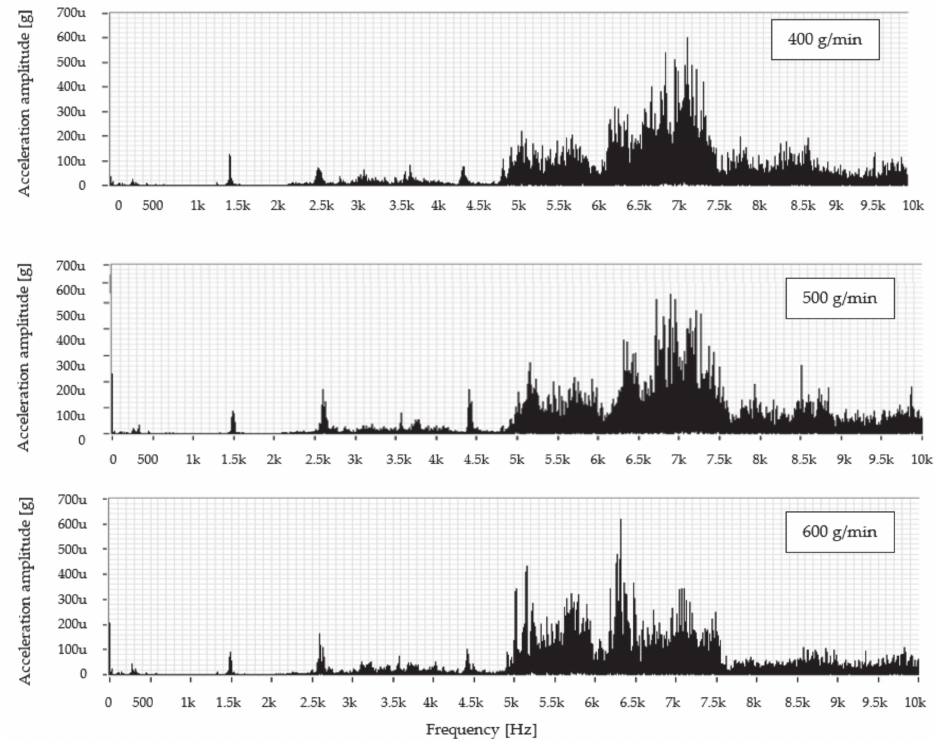
Figure 8. Frequency spectra of vibration acceleration amplitude versus frequency for abrasive mass flows at a feed rate of 100 mm/min for abrasive